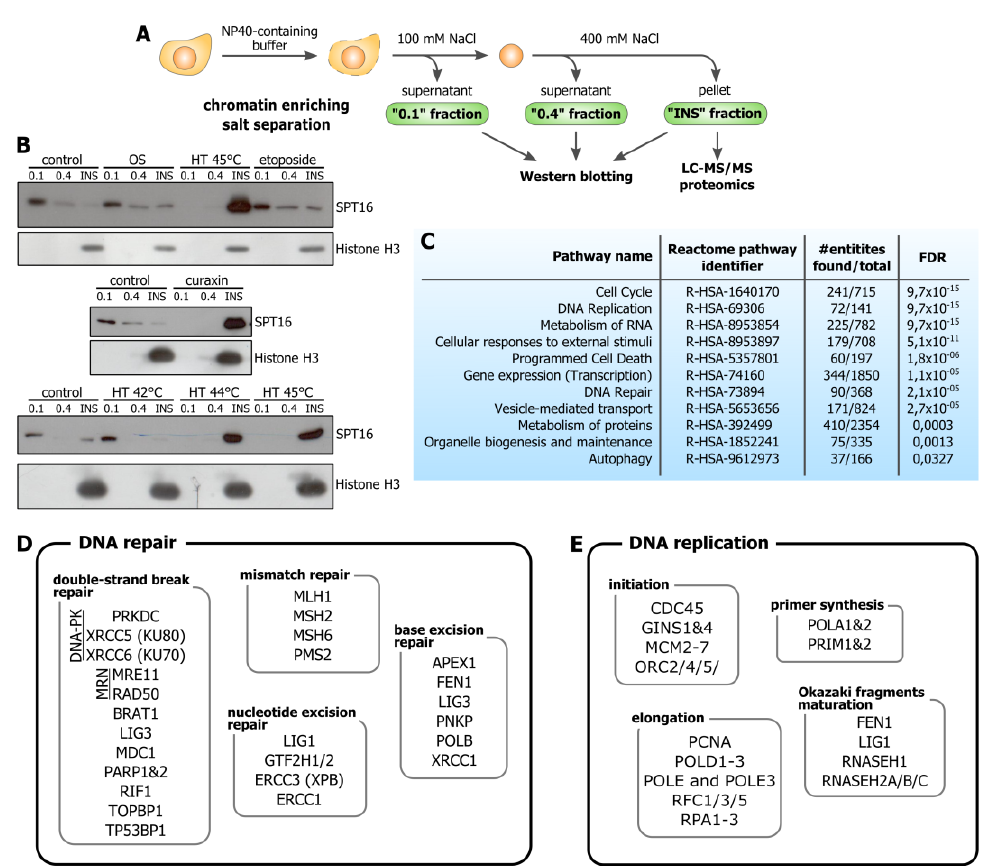
Figure 1. Identification of proteins that can be trapped to chromatin by hyperthermia. ( A ) Schematic representing chromatin enriching salt separation used in this study. Protein fractions obtained using this approach (green boxes) were analyzed by Western blotting or LC-MS/MS-based proteomics. ( B ) Western blot analysis of SPT16 (FAcilitates Chromatin Transcription (FACT) subunit) and histone H3 in different chromatin fractions (see ( A )) prepared from control HeLa cells and HeLa cells treated either with hypoosmotic stress (OS; 150 mOsmol, 60 min), hyperthermia (HT; 42, 44, or 45 °C, 30 min), etoposide (20 µg/mL, 60 min) or curaxin CBL0137 (10 µM, 60 min). ( C ) Significantly enriched Reactome top-level (parent-level) pathway terms in the list of proteins undergoing c -trapping in response to hyperthermia. FDR, false discovery rate. For additional details, see Supplementary Material Table S2. ( D , E ) DNA repair ( D ) and DNA replication ( E ) proteins identified as c -trapped in hyperthermia are grouped according to their role in specific pathways.